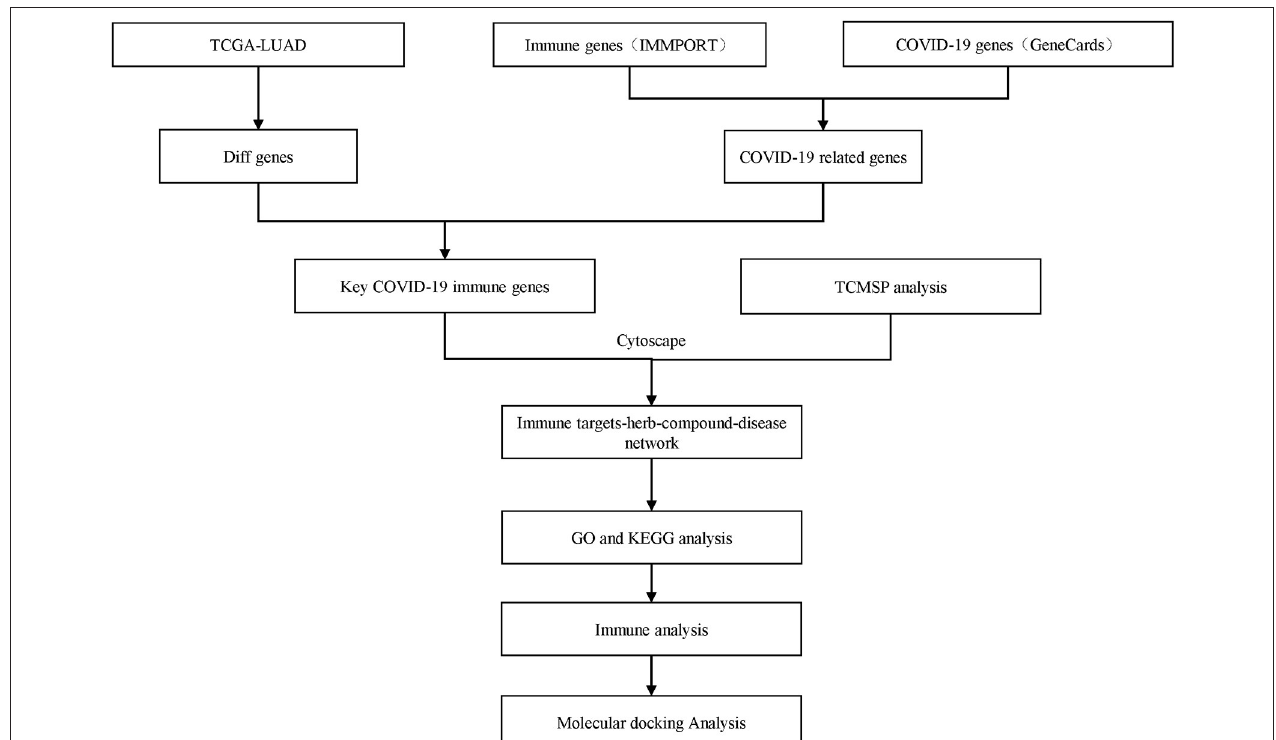
FIGURE 1 | Workflow